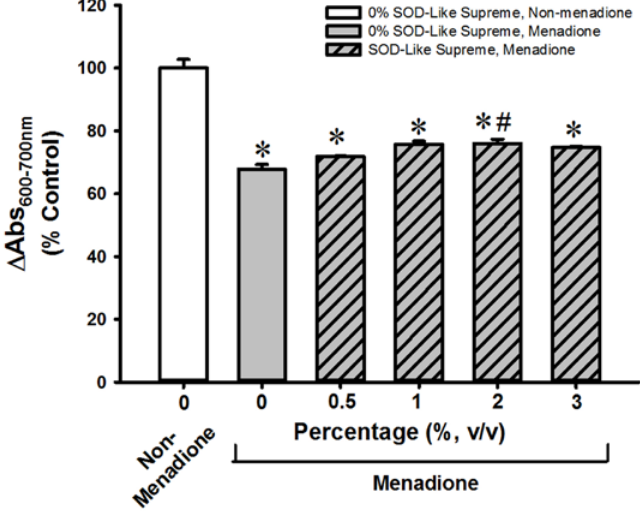
Figure 1. Effects of SOD-Like Supreme on cell viability of H9c2 cells following menadione challenge. After co-incubation of H9c2 cells with SOD-Like Supreme and menadione, cell viability was assessed by the MTT assay, as described in Materials and Methods. The difference between absorbance at 600 nm and absorbance at 700 nm of non-menadione control is 0.72 ± 0.04 (mean ± SD). Data are expressed as % of the non-menadione controls by normalizing relative to the value of non-menadione-incubated cells. Values given are means ± SD, with n = 4. * Significantly different from the non-menadione controls; # Significantly different from the menadione control group. SOD, superoxide dismutase; SD, standard deviation.